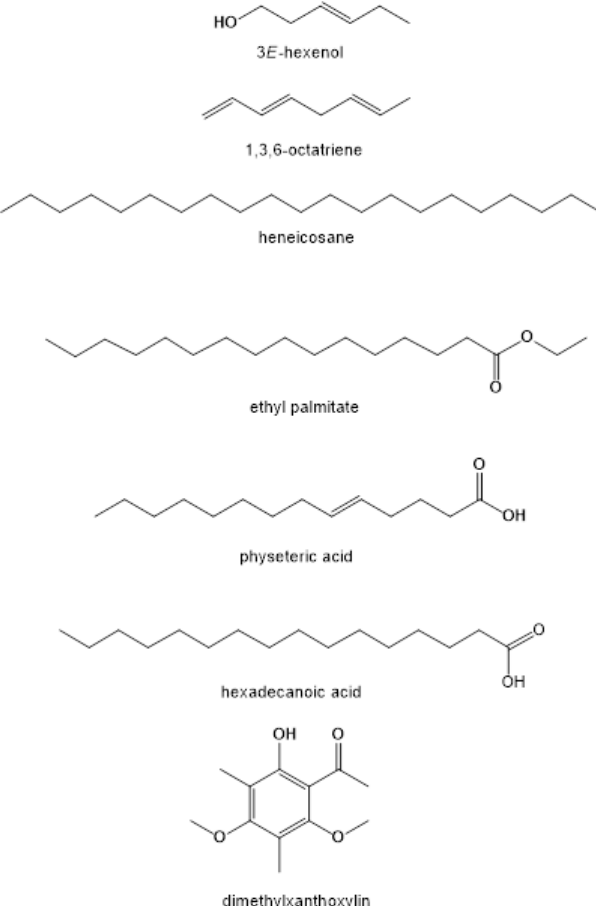
Figure A3. Major oxygenated sesquiterpenes found in Eugenia and Syzygium essentials oils.